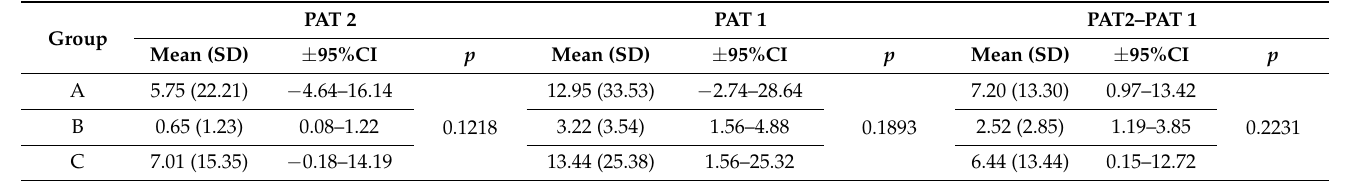
Table 3. Descriptive statistics of PAT 2 and PAT 1 and the PAT difference, divided into